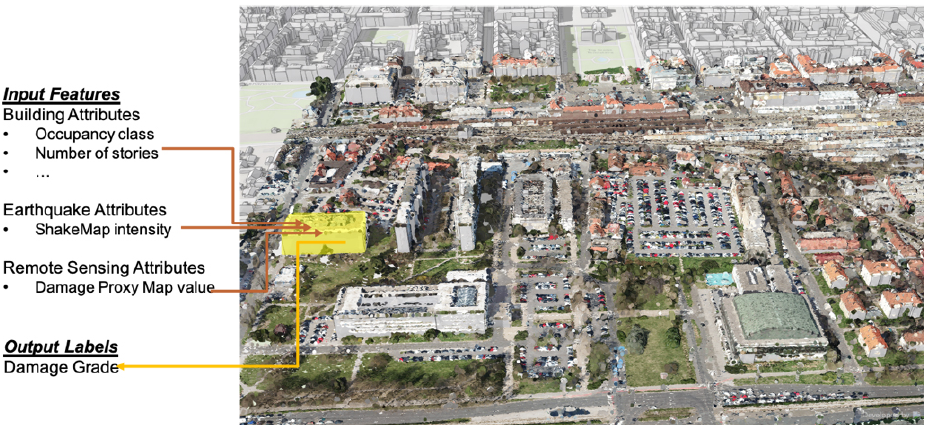
Figure 4. Illustration of the input feature vector and output label vector for a selected building in Zagreb (map source: Office for Strategic Planning and City Development, City of Zagreb; URL: